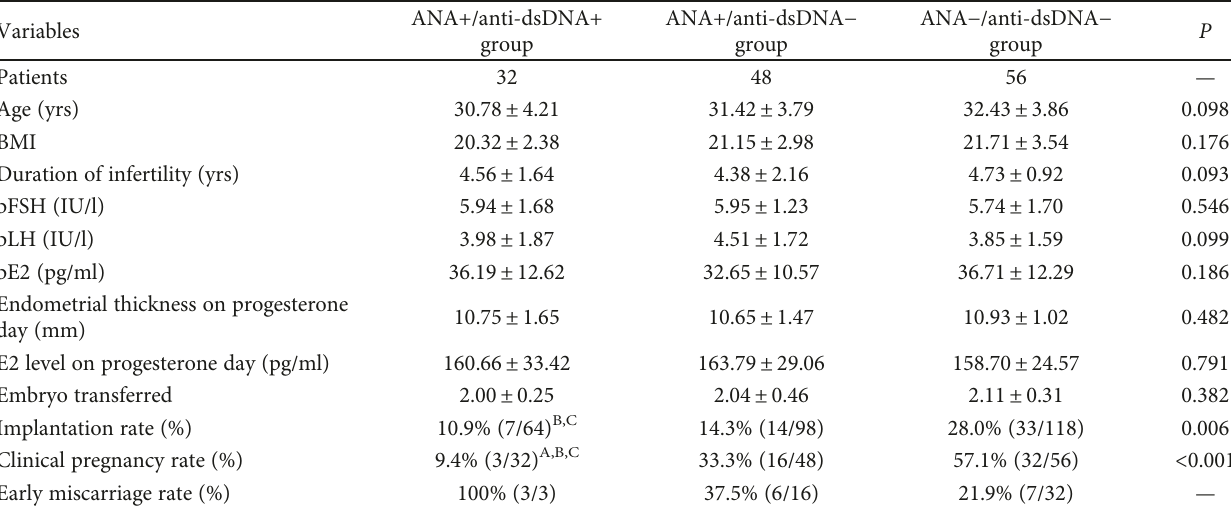
Table 3: Basal characteristics and HRT-FET outcomes among the three